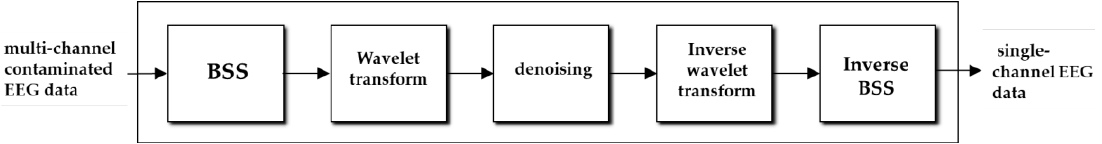
Figure 5. Process flow of BSS-WT method.